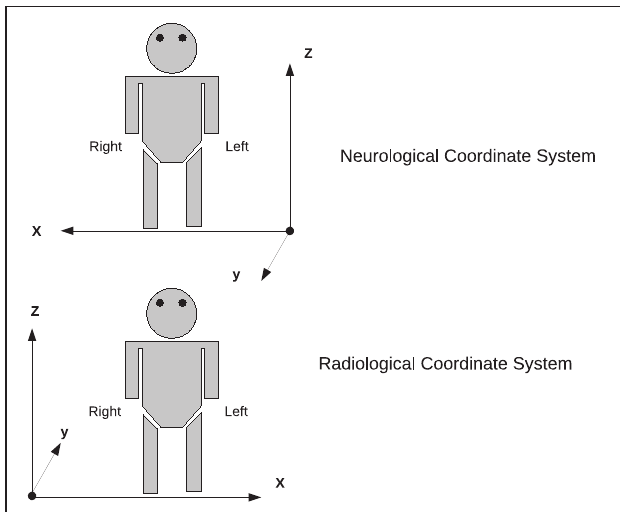
FIGURE 5 | Two coordinate systems for determining subject orientation. The neurological coordinate system defines the positive X , Y , and Z axes along the subject’s right, anterior, and superior, respectively. The radiological coordinate system defines the positive X , Y , and Z axes along the subject’s left, posterior, and superior, respectively.